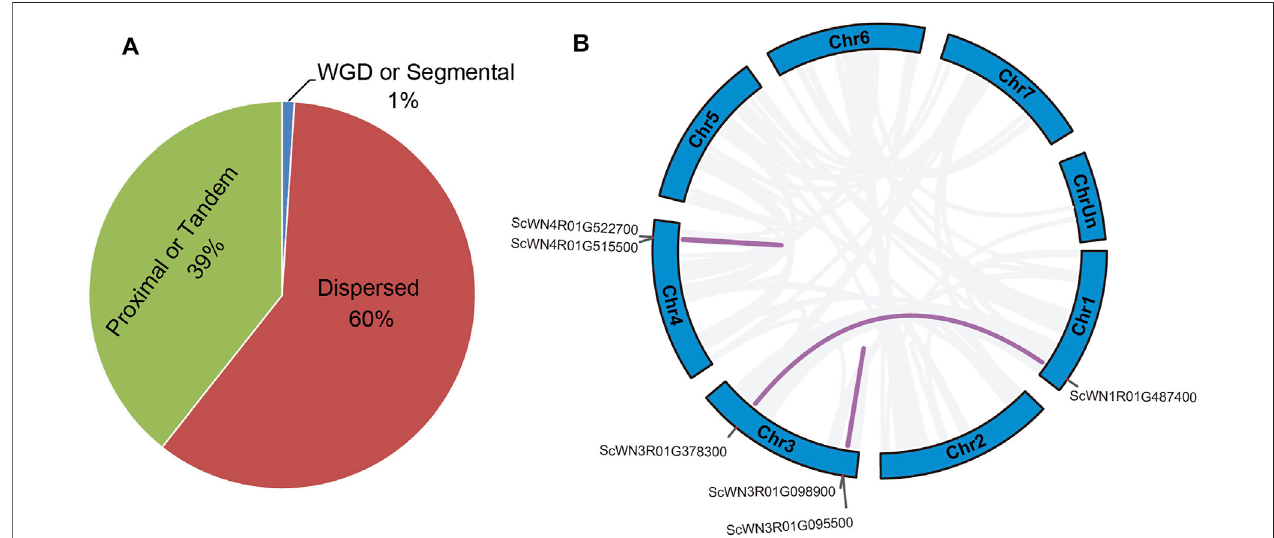
FIGURE 3 | Duplication type for NBS-LRR genes in S. cereale . (A) Proportion of NBS-LRR genes with different duplication types. (B) Segmental duplicated NBS- LRR gene pairs in S. cereale.